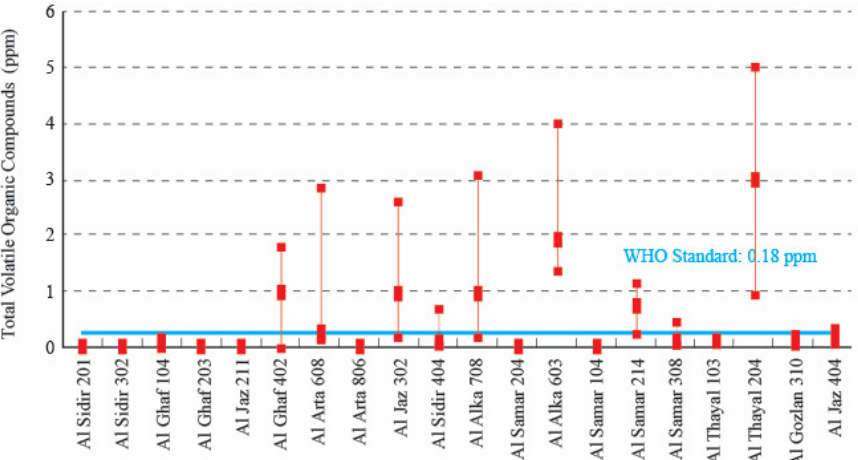
Figure 6. TVOC concentrations in 20 housing units at The Greens, Dubai.